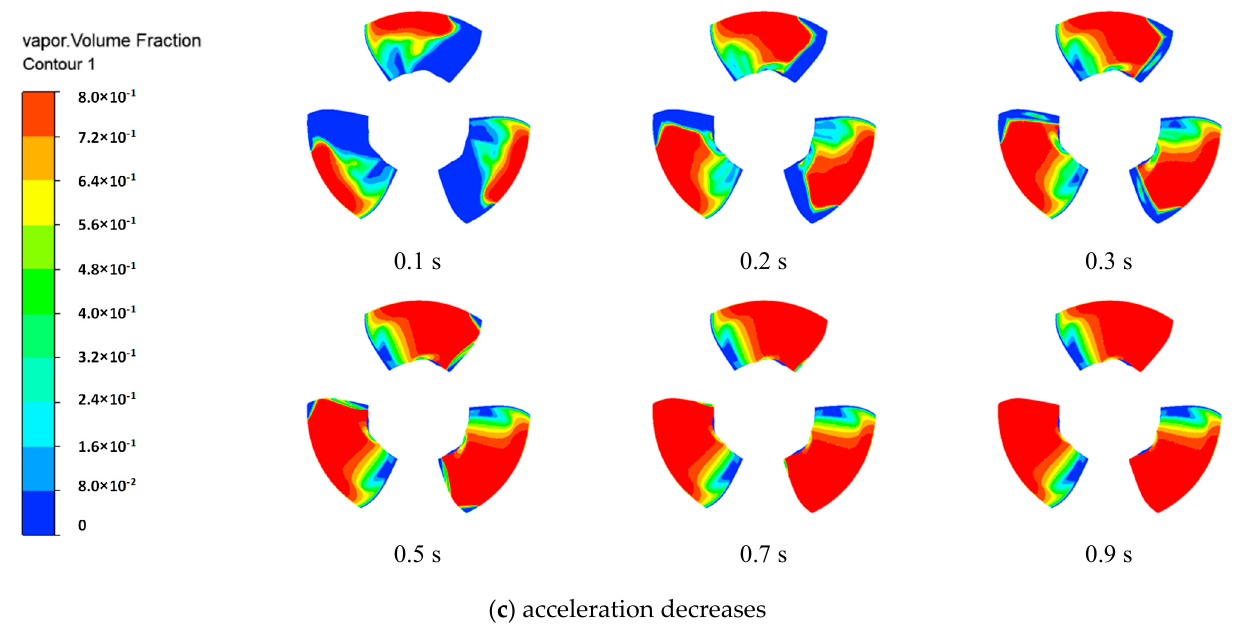
Figure 8. Cloud diagram of cavitation volume fraction on the back of the blade.